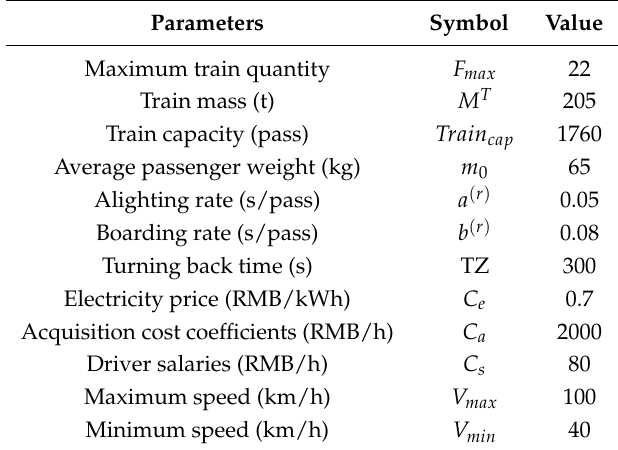
Table 2. Parameter settings in the numerical experiments.